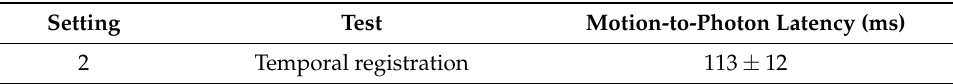
Table 3. Temporal registration errors.